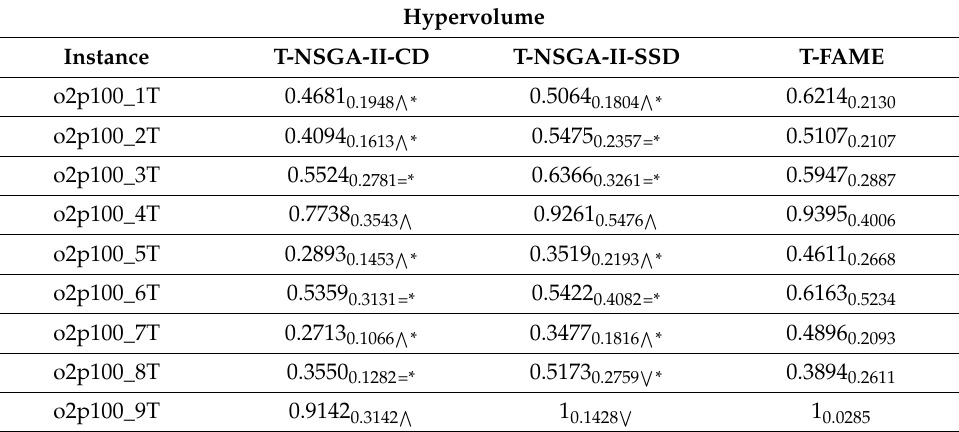
Table 13. Results with the hypervolume metric.